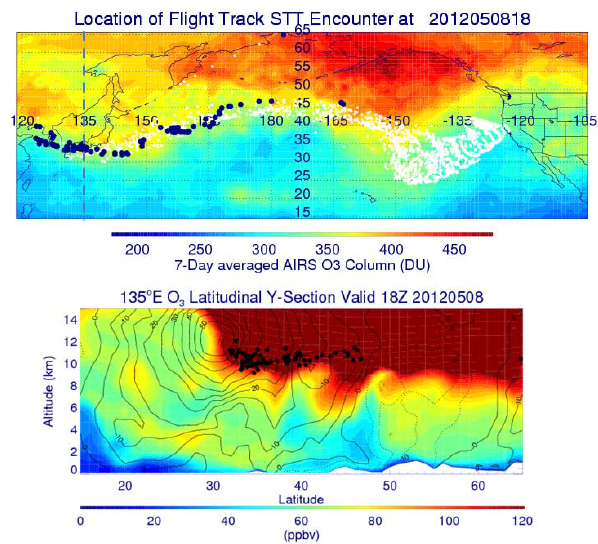
Fig. 6. Map of 7-day averaged (7–14 May 2012) AIRS total col- umn O 3 (DU, top) with the STT back trajectory history (white) and locations of the high (>120ppbv) RDF O 3 mixing ratios (blue). RAQMS 135 ◦ E O 3 (ppbv) and zonal wind (black contours, ms − 1 ) cross section (bottom) with locations of the high (>120ppbv) RDF O 3 mixing ratios (blue dots) at 18:00UTC on 8 May 2012 for anal- ysis of AJAX flight on 14 May